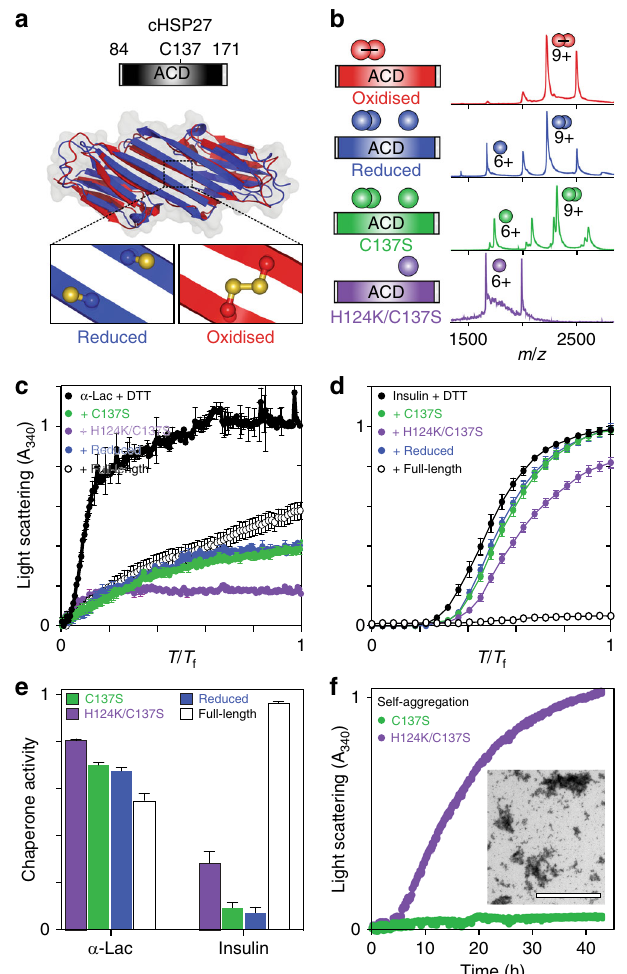
Fig. 3 cHSP27 monomers are potent chaperones in vitro. a The central ACD exists as a stable dimer in which residue C137 at the dimer interface can access both reduced (blue, PDB 4mjh) and oxidised (red, PDB 2n3j) states. b The cHSP27 variants used in this study together with their native mass spectra at 5 μ M. For reduced cHSP27, 250 μ M DTT was added. c Aggregation of 300 μ M α -lactalbumin ( α Lac; black) at 37 °C and d 80 μ M insulin at 40 °C following the addition of 2 mM DTT, both monitored by light scattering at 340 nm. The values of T f are 10 ( c ) and 0.3 ( d ). Aggregation of both proteins is inhibited by C137S (green), reduced cHSP27 (blue), H124K/C137S (purple), and full length HSP27 (empty). For α Lac and insulin, the sHSP concentrations were 70 and 40 μ M, respectively. The traces represent the average of three experiments with errors bars indicating ± 1 SD. Under these conditions, C137S and reduced cHSP27 are predominantly dimeric whereas H124K/C137S is monomeric e Relative chaperone activity of the cHSP27 variants from panels c and d , with activity de fi ned as one minus the ratio of the average signal with and without chaperone. f The self-aggregation of 800 μ M C137S and H124K/ C137S monitored by light scattering at 340 nm at 37 °C. The traces represent the average of six (C137S) or three (H124K/C137S) experiments with error bars indicating ± 1 SD. Inset: A representative transmission electron microscopy (TEM) micrograph at 40 h reveals large, non- fi brillar aggregates of